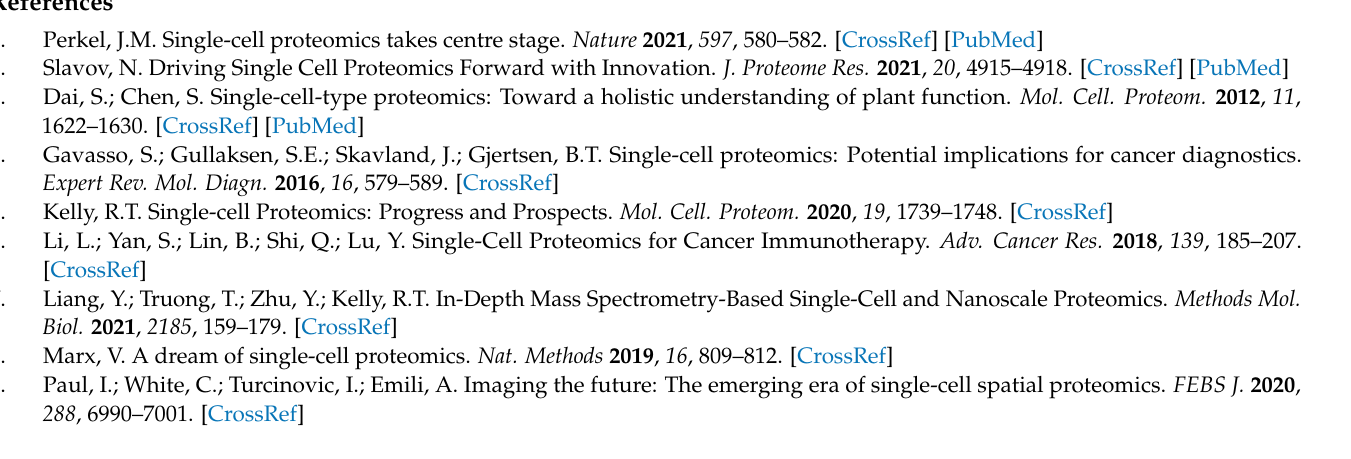
Figure S3. Hierarchical clustering heatmap of protein intensities (IPM) for all proteins identified in the single cells of HPDE and